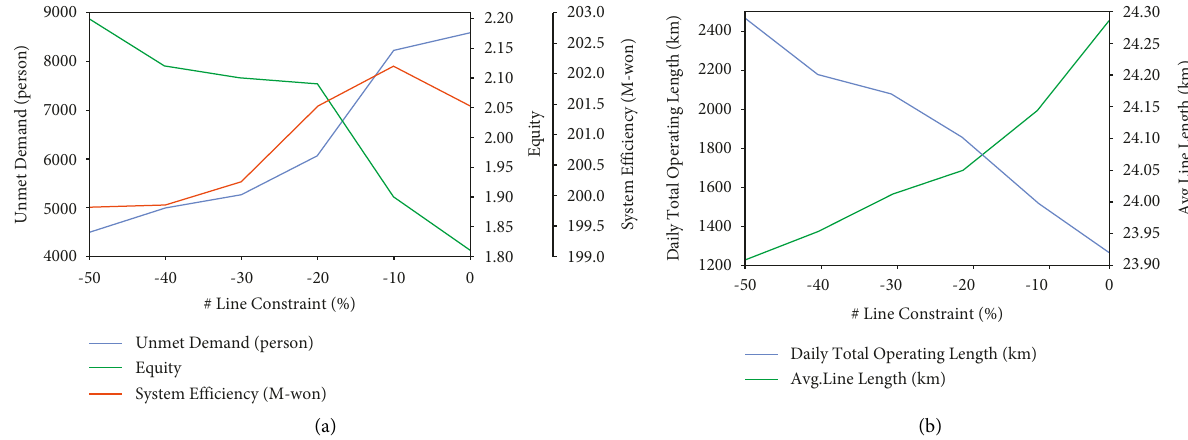
Figure 16: Sensitivity analysis for the constraint on the number of lines. (a) The three objective functions. (b) Daily total operating length and average line